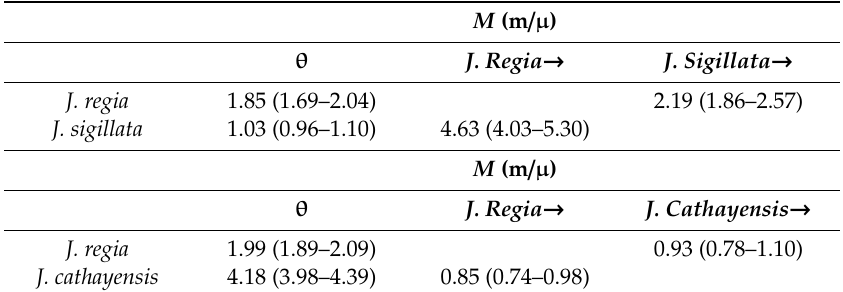
Table 3. Estimated gene flow between sympatric J. regia and J. sigillata populations in Yunnan Province and J. regia and J. cathayensis populations in Qinling Mountains by Migtate